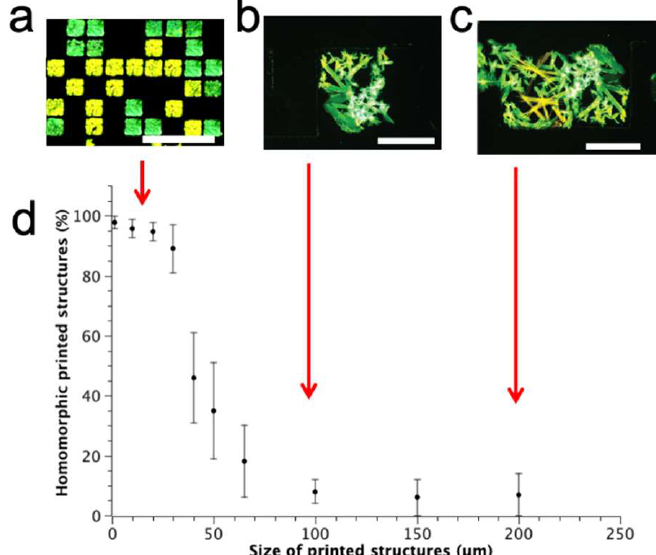
Figure 4. Polymorph composition homogeneity versus confinement size in printed structures of compound 1 : ( a ) Fluorescence image of compound 1 deposited in 20 × 20 µm 2 structures, ( b ) 100 × 100 µm 2 , and ( c ) 300 × 200 µm 2 . Bars are 80 µm in length; ( d ) Trend of percentage of printed struc- tures containing only one polymorph vs. size.